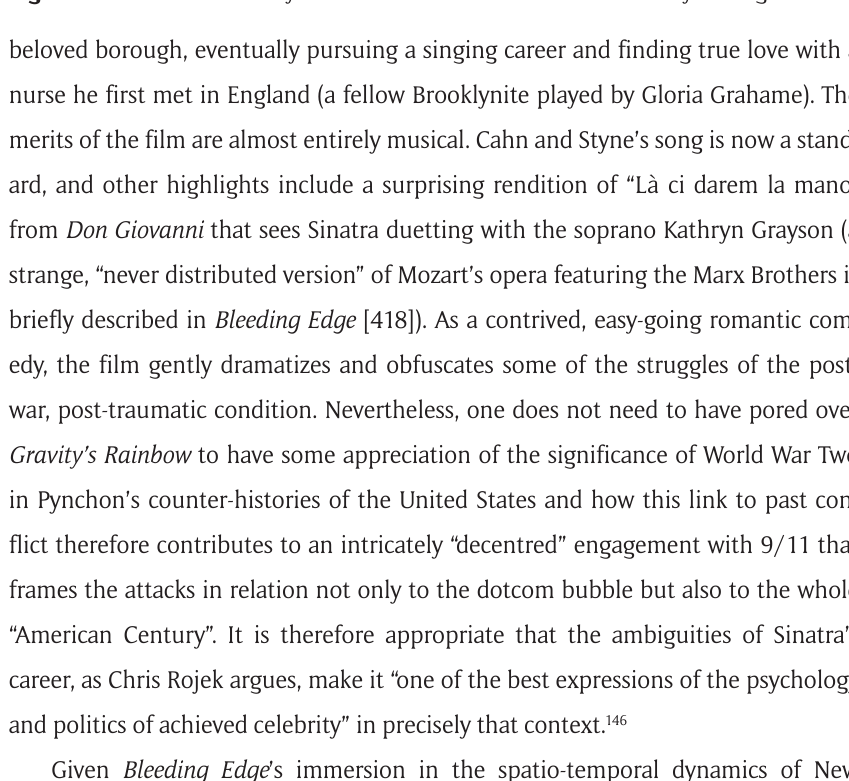
Figure 5: “Isn’t she a beauty?” Frank Sinatra as GI Miller on Brooklyn